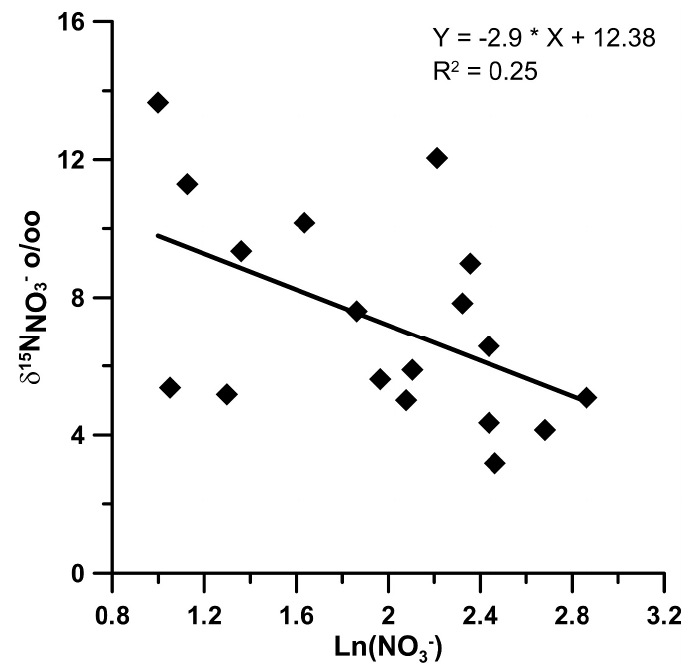
Figure 5. Linear regression of 15 N on ln(NO 3 ), where ln(NO 3 ) is the fraction of the original pool of nitrate still present. The slope of the regression is equal to the isotopic enrichment factor ε (here − 2.9‰) for denitrification in the streams.